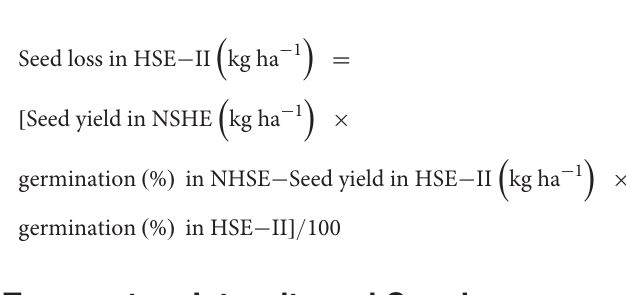
FIGURE 1 | Average daily weather conditions of the experimental site during the period of